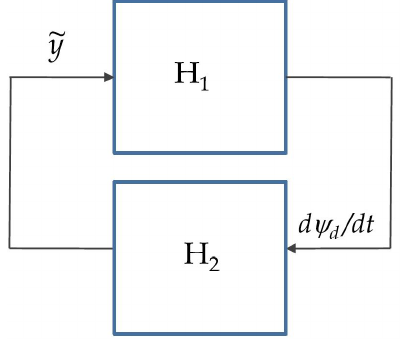
Figure 9. General feedback